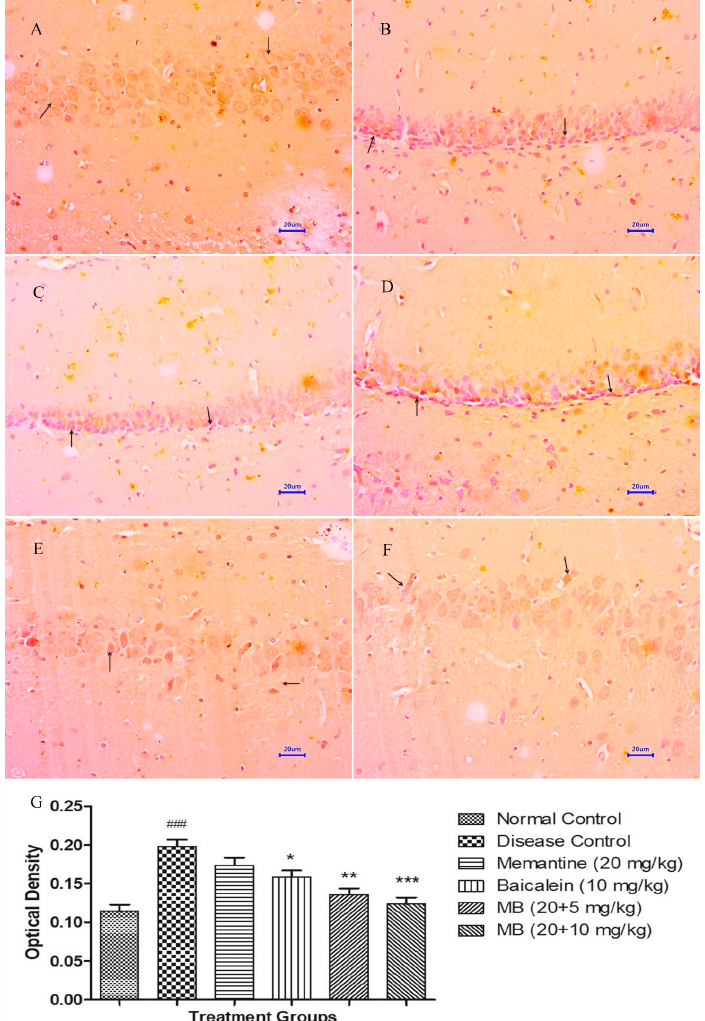
Figure 10. Effect of A β (1–42), baicalein and baicalein with memantine on β -amyloid expression in hippocampus (400 × ). ( A ) Normal control: displaying morphologically normal neuronal cells (arrow) in hippocampus. ( B ) Disease control: displaying moderate to markedly enhanced β -amyloid deposition (arrow), exhibited by brown colouration in hippocampus. ( C ) Memantine 20 mg/kg: displaying mild β -amyloid deposition (arrow) exhibited by brown colouration in hippocampus. ( D ) Baicalein (10 mg/kg): displaying mild to moderate β -amyloid deposition (arrow) exhibited by brown colouration in hippocampus. ( E ) Memantine + Baicalein (20 + 5 mg/kg): displaying mild to moderate β -amyloid disposition (arrow) exhibited by brown colouration in hippocampus. ( F ) Memantine + Baicalein (20 + 10 mg/kg): displaying mild β -amyloid deposition (arrow) exhibited by brown colouration in hippocampus. ( G ) OD data for ICH. Data are represented as mean ± SEM, where ### p < 0.001 indicates comparison with normal control, whereas * p < 0.05, ** p < 0.01 and *** p < 0.001 indicates comparison with disease control group; SEM, Standard Error of Mean; MB: memantine + baicalein; IHC: Immunohistochemistry.